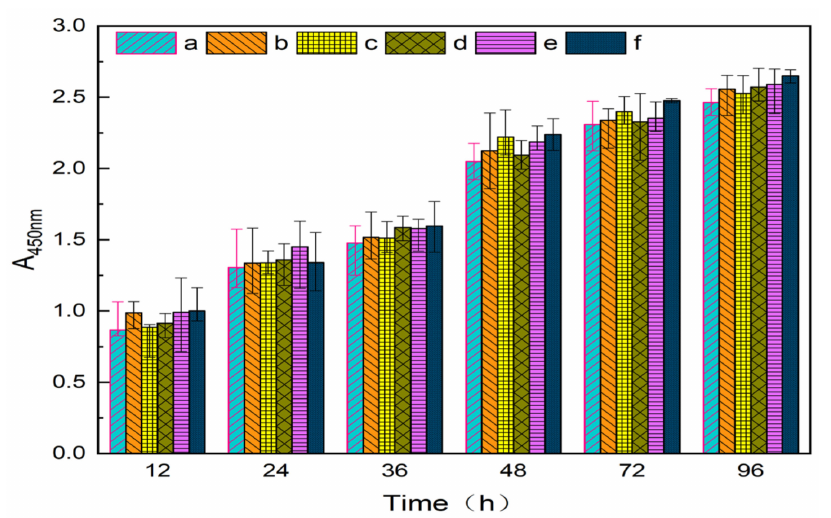
Figure 12. Cytotoxicity of nanofiber membranes in ( a ) blank group and ( b ) NC0, ( c ) NC2, ( d ) NC4, ( e ) NC6 and ( f )